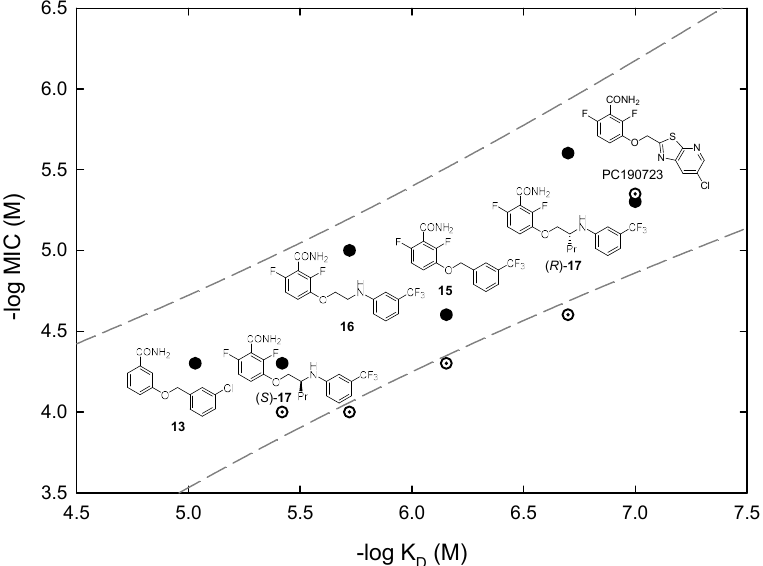
Figure 7. Correlation of antimicrobial activity (MIC) with binding affinity ( K D ) of inhibitor binding to the BsFtsZ benzamide site at the interdomain cleft. Data from representative analog compounds are shown together with their chemical structures. Filled circles, B. subtilis MIC; dotted circles, methicillin-resistant S. aureus MIC. The dashed lines are the 95% predictive intervals for B. subtilis MIC vs K D values of 15 analogs